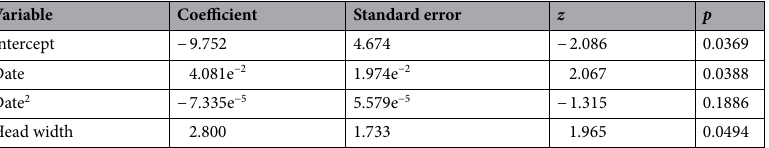
Table 2. Results of polynomial regression assessing the effect of Date (number of days since January 1), Date 2 and Head width as a covariate on the probability of being mated for 149 P. downsi females captured between September 2015 and March